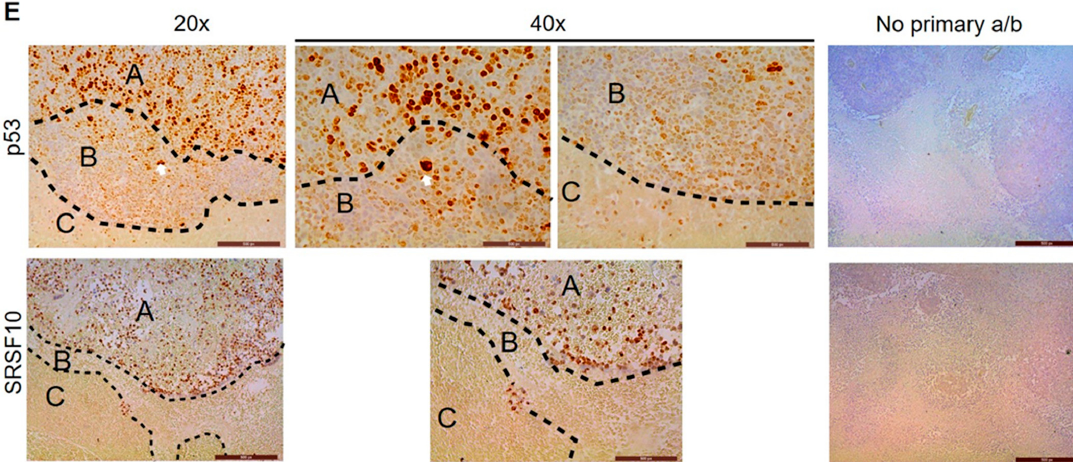
Figure 5. Non-epithelial staining of mutant p53 in clinical samples. Mutant p53-specific immunohistochemistry of resected tumors from CRC patients were sequenced and the TP53 status was determined. Eight cases were stained using the anti-R175H antibody. ( A ) Mouse tail-tip fibroblasts expressing wild-type (WT) p53, heterozygous for p53 (+/ − ), and heterozygous for mutant R172H p53 (172/+) were treated without (Ctrl) or with 10 Gy g-irradiation (IR) and harvested 2 h later and used for immunoblot analysis. IC12 is a pan-p53 antibody that detects all forms of p53. The a-R172H antibody is specific for the R172H mutation (human R175H). Loading was controlled with b-actin antibody. ( B ) Representative WT case with no DO-1 (anti-p53) staining detected. ( C ) Two representative mutant p53 R175H images in which specific nuclear positive DO-1 staining is detected in tumor nests as well as in areas outside the tumor nests. ( D ) Non-epithelial areas in the R175H cases where nuclear staining is detected; bars = 50 µm. ( E ) Colo-320DM human colorectal cells were used to generate xenograft tumors, which were harvested and stained with DO-1 antibody to detect mutant p53 expression or the SRSF10 antibody to mark cells of human origin. Representative images are shown. White arrows are for orientating the images and area “A” marks the tumor core tissue. Areas “B” and “C” show the presence of mutant p53 stains in non-tumor tissues as they are not stained by the SRSF10 antibody. Negative control images of tumors stained without primary antibodies are shown. Images denoted with 20× and 40× represent a 200× and 400× magnification respectively. Images of staining without primary antibodies are 100× magnified ( F ) Suggested model: Mutations in p53 are a common event in many cancer types. When a tumor cell acquires a GOF mutation in p53, it will release EVs enriched with the mutant p53 protein. Such EVs are taken up by neighboring tumor cells, macrophages, fibroblasts, and other tumor microenvironment (TME) members. Expression of mutant p53 in target cells will result in oncogenic mechanisms in the TME, which drives tumor progression and eventually metastasis.